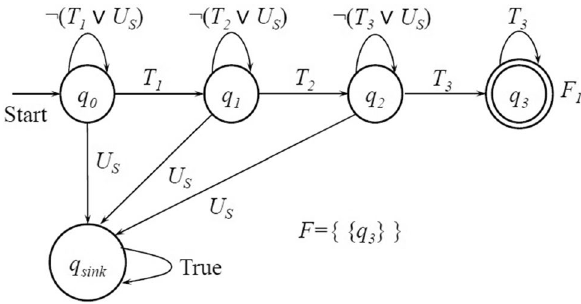
U s ♦ ( T 1 ♦ ( T 2 ♦ T 3 )) = ∧ ∧ ∧ ¬